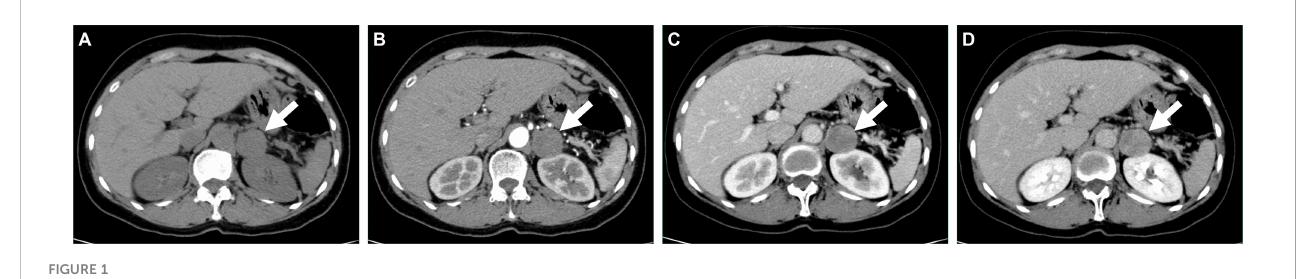
FIGURE 1 (A – D) CT of the patient before surgery.